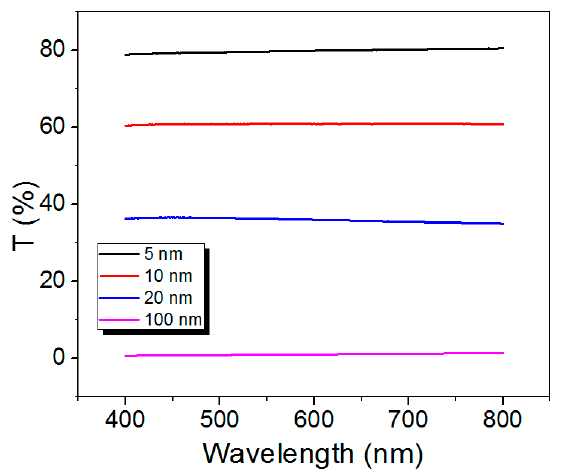
Figure 6. Optical transmittance (T) of a CoSiB TFMG of the different thickness (5, 10, 20, 100 nm) at wavelengths scanned from 400 nm to 800 nm using a UV-VIS spectrophotometer. wavelengths scanned from 400 nm to 800 nm using a UV-VIS